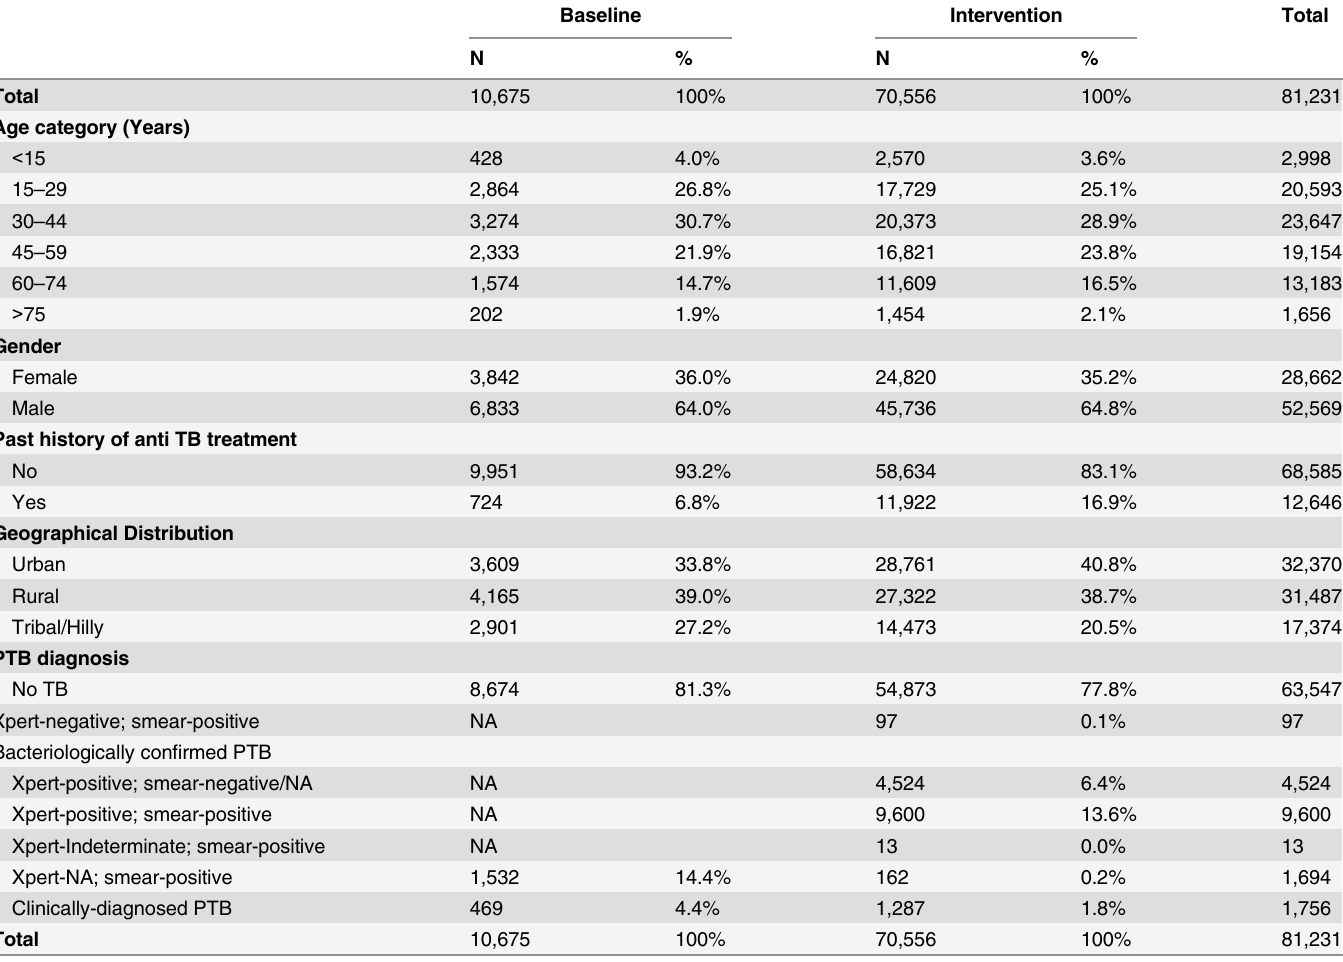
Table 1. Characteristics of persons tested for pulmonary tuberculosis by study phase, at the 14 study treatment units with data collection both in the baseline and intervention